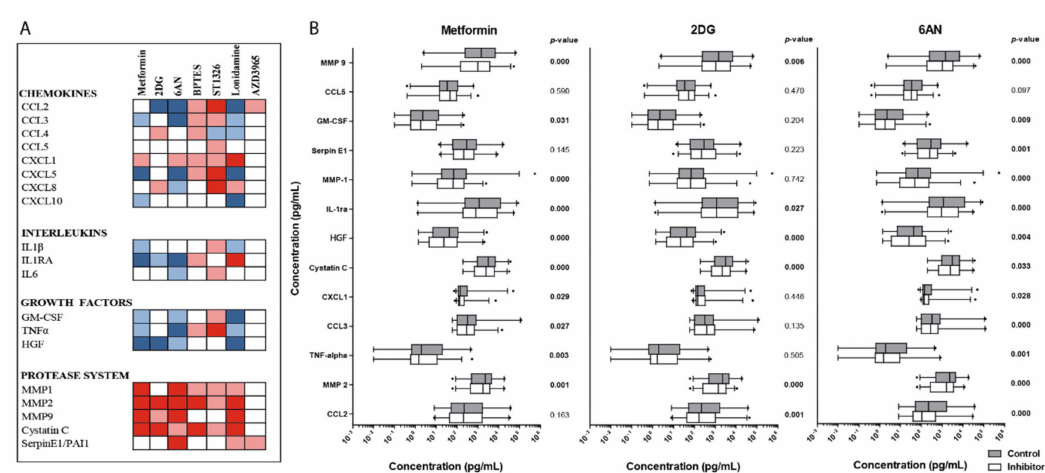
Figure 6. The e ff ects of metabolic inhibitors on the constitutive release of soluble mediators by primary human AML cells. Primary AML cells from 72 patients were cultured for 48 hours with and without metabolic inhibitors before the concentrations of 19 soluble mediators were determined in supernatants using multiplex analysis. ( A ) Overall e ff ects of metabolic inhibitors on the release of soluble mediators by AML cells. Concentrations were—metformin 2.5 mM, 2DG 0.6 mM, 6AN 100 µ M, BPTES 20 µ M, ST1326 50 µ M, lonidamine 300 µ M and AZD3965 200 nM. Mediator levels found in treated cultures were compared to untreated control cultures and increased levels after inhibitor treatment are shown in red, while decreased levels are shown in blue. Significant changes are indicated by the color grading ( p < 0.05 light color, p < 0.001 dark color, Wilcoxon signed rank test). ( B ) Changes in the constitutive release of soluble mediators by metformin 2.5mM, 2DG 0.6 mM and 6AN 100 µ M. Mediator concentrations measured in cultures after 48-hour treatment with metabolic inhibitors (white boxes) and untreated control cultures (grey boxes) are presented, with the median levels, 25 / 75 percentiles (boxes), 5 / 95 percentiles (whiskers) and outliers. The mediator concentrations are given on the X-axis as log-values. P -values are shown for significantly altered mediator concentrations when comparing treated cultures with untreated controls (Mann-Whitney U